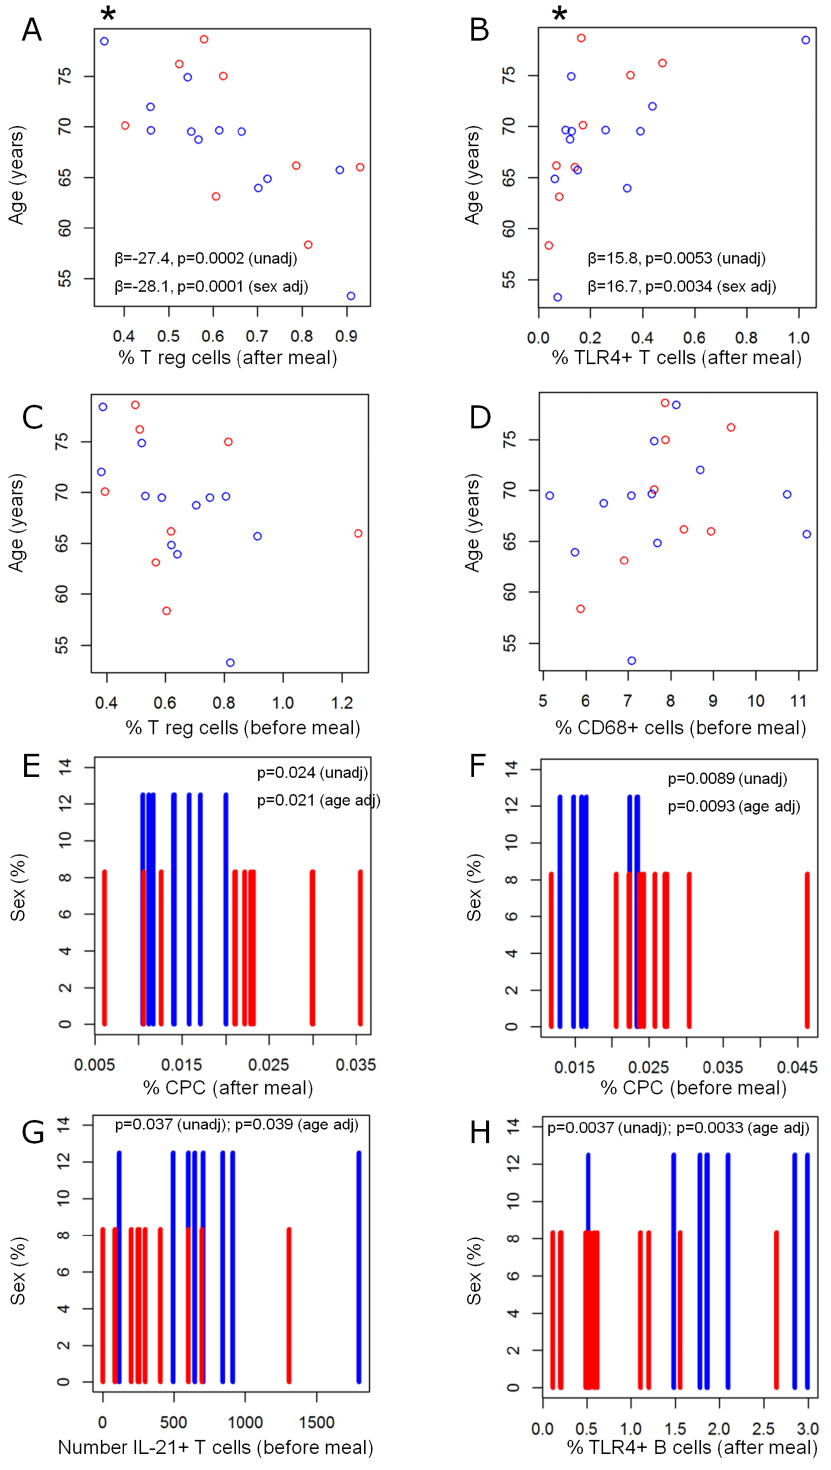
Figure 7. Age (years) vs after meal frequency of CD3 + CD4 + CD25 + CD127 2 T cells (A), after meal frequency of CD3 + CD4 + IL21R 2 TLR4 + T cells (B), before meal frequency of CD3 + CD4 + CD25 + CD127 2 T cells (C) and before meal frequency of CD68 + macrophages (D). Red dots represent women and blue dots represent men. Distribution of men and women separately vs after meal frequency of CD31 + CD34 + CD45 dim CD133 dim CPCs (E), before meal frequency of CD31 + CD34 + CD45 dim CD133 dim CPCs (F), before meal number of resting IL-21 + T cells (G) and after meal frequency of CD19 + IL21R 2 TLR4 + B cells (H). Red bars represent women and blue dots represent men. (A and B *=significant after adjustment for multiple testing).